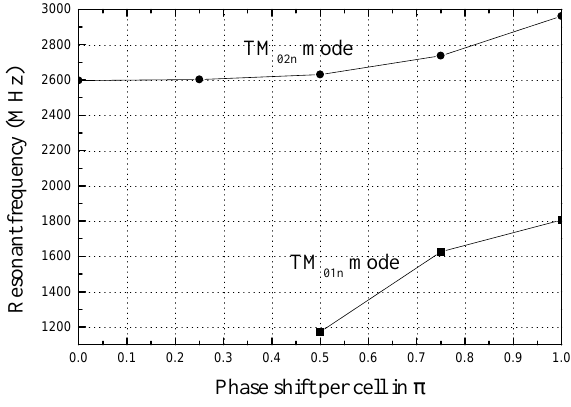
FIG. 6. Dispersion curves for the 4-cell PWT structure.